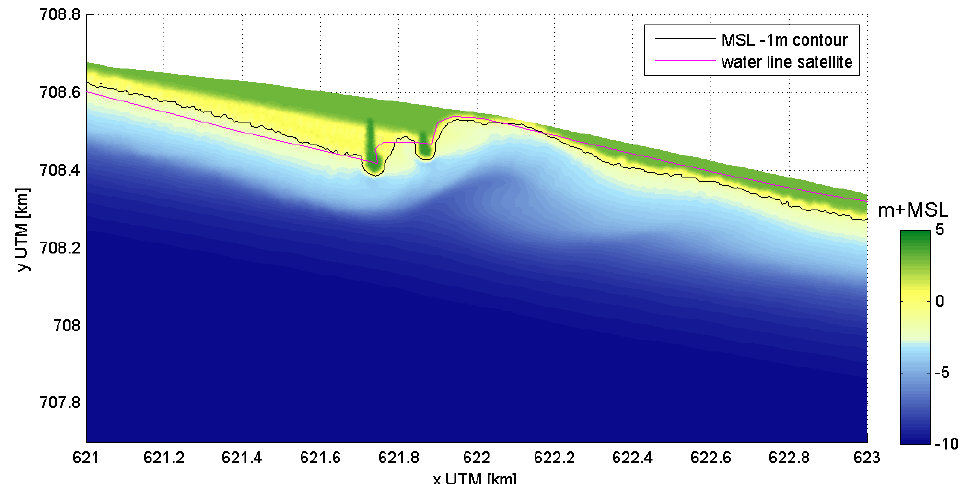
Figure A4. Bathymetry at the end of the calibration simulation.